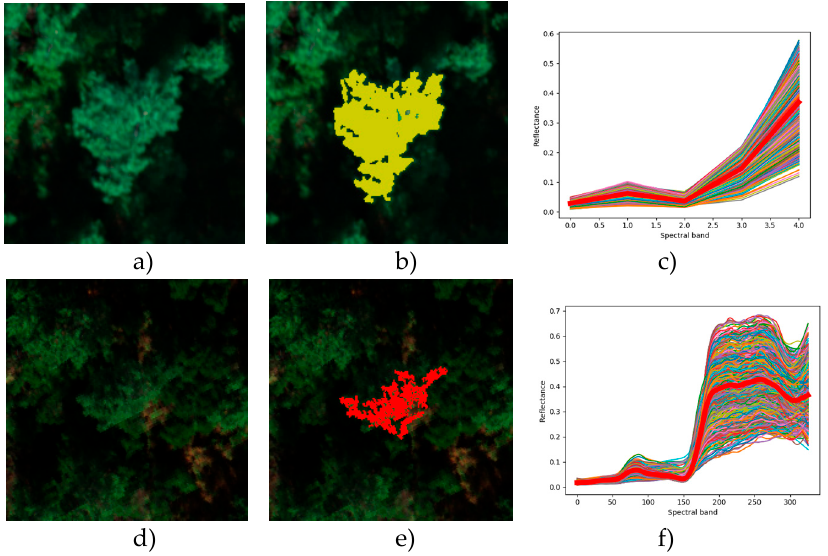
Figure 4. Example of RGB representation of image part (left: a , d ), delimited tree crowns (center: b , e ) and extracted spectra of all crown pixels (right: c , f ) for multispectral and hyperspectral data (top and bottom, respectively); the thick red curves represent averages of extracted spectra.